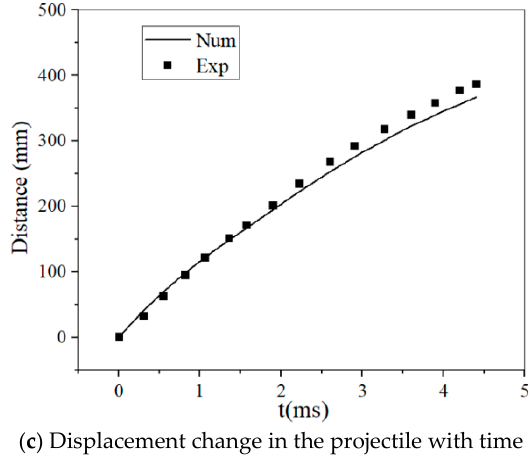
Figure 6. Comparison between simulation results and experimental data [16].